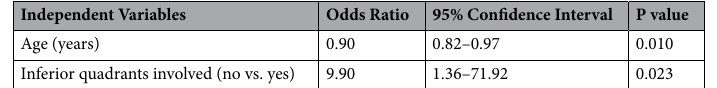
Table 3. Multivariate Logistic Regression of Risk Factors for Surgery Success.